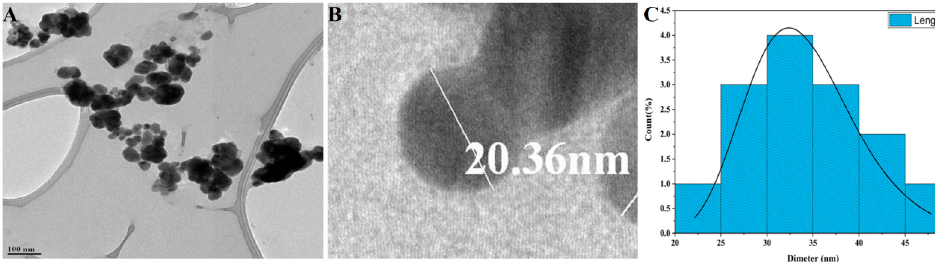
Figure 5. SEM with EDX analysis of synthesized P-AgNPs from P. alba leaf extract ( A ) SEM image showing surface morphology, ( B ) EDX spectrum indicating the presence of silver.